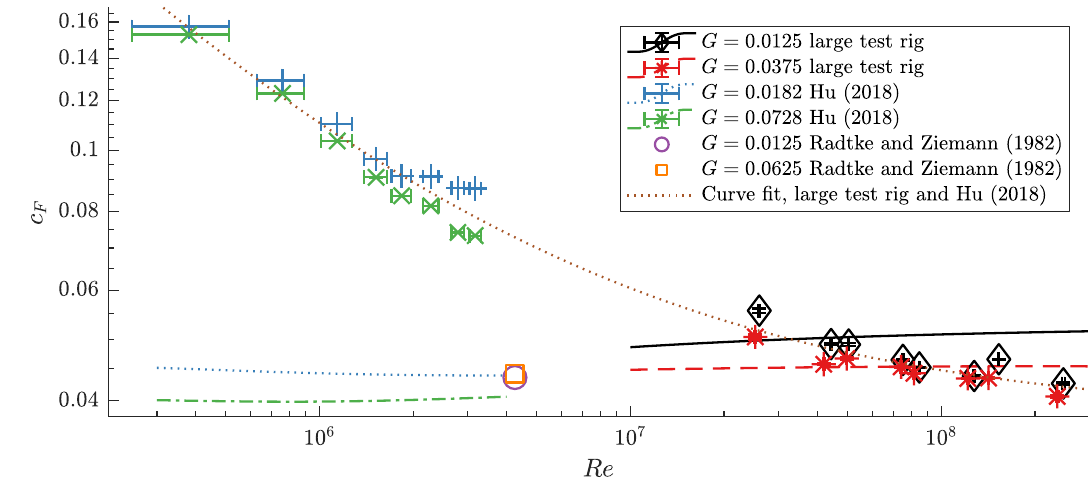
Figure 4. Change of axial thrust coefficient c F with Reynolds number Re . Markers are measurements of the large test rig, the small test rig by Hu [10], and the test rig by Radtke and Ziemann [3]. Lines of the same colour as a set of markers are predictions by the models given in [2]. Lines and markers of the same colour share operating conditions, i.e. their axial cavity widths G are the same for both the large and small test rig. The final curve is a best fit to the measurement results of the large test rig and the data of Hu [10]. Uncertainties are neglected in the